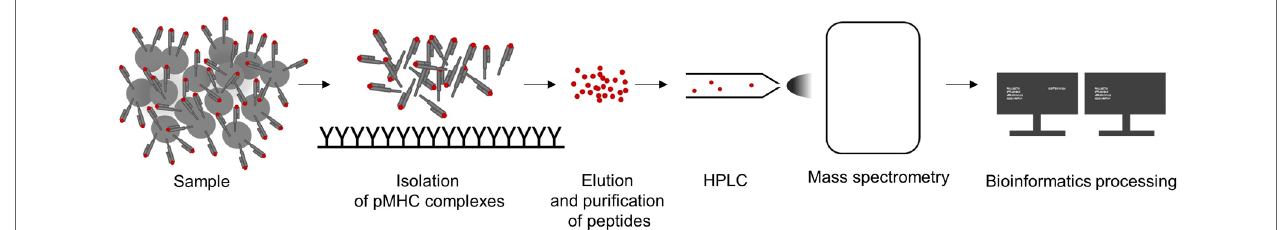
FIGURE 2 | Workflow to analyze of major histocompatibility complex (MHC)-eluted peptides by mass-spectrometric (MS). A sample is lysed, pMHC complexes are captured and peptides are purified by immunoaffinity purification using MHC-specific immobilized antibodies. Eluted peptides are separated by high pressure liquid chromatography (HPLC), analyzed by MS, and the resulting data are computationally